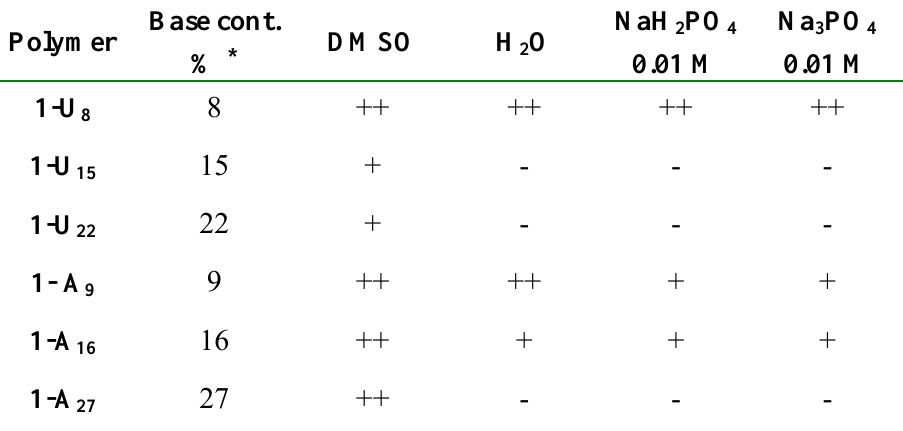
Table 1 . Solubility of 1-U and 1-A